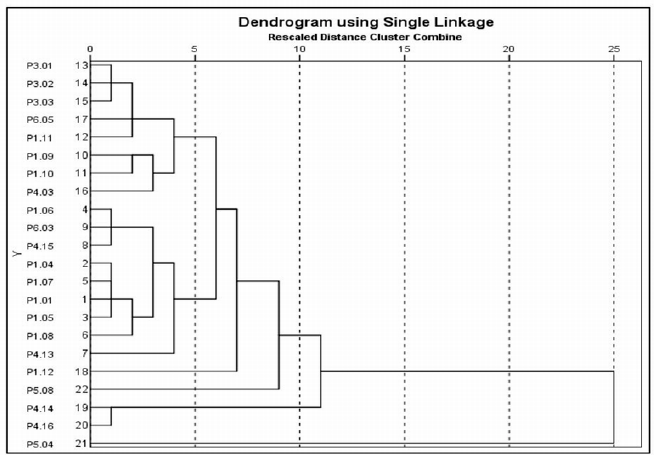
Figure 4. Dendrogram clustering analysis using “Single Linkage” method of the study means, and study SDs among 21 included studies in the subgroup meta-analyses. Table 3. Study size (N), mean, SD, coefficient of variations (CV), and cluster membership of the included studies.